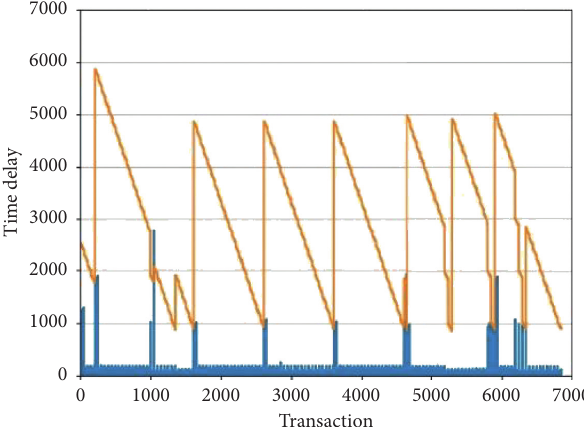
Figure 11: Comparison of transaction delay between two stages.